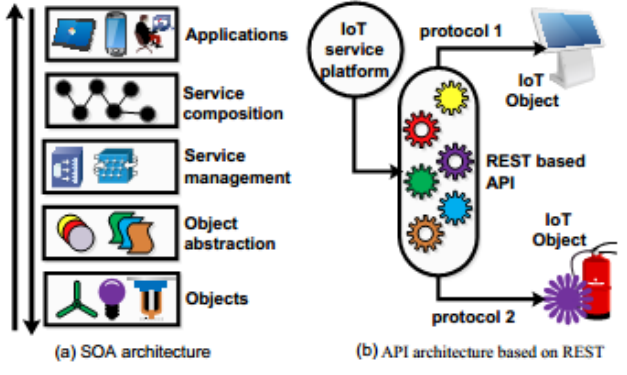
Figure 6. Types of IoT